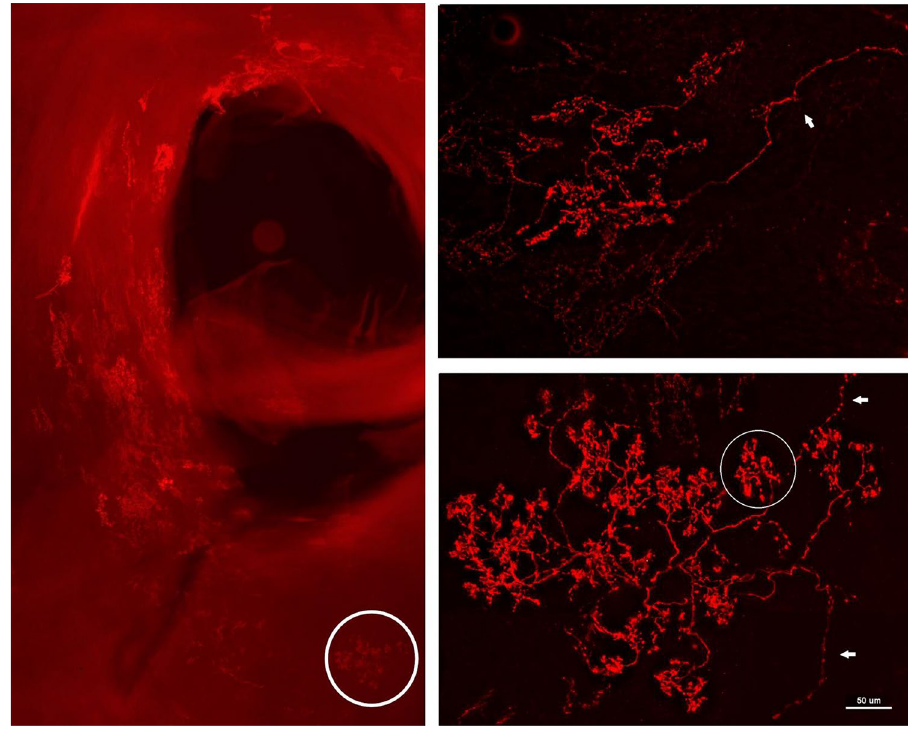
Figure 1. Illustration of baroreceptors in aortic artery. Left: baroreceptor distribution. The sensory receptors are clustered in different areas along the aortic artery. They are more concentrated in the bifurcation origin of the common carotid and subclavian arteries. The white circle shows the BR structure illustrated on the right (bottom). Right: sensory structures presented in compact clusters resembling bunches of grapes. Morphologically, receptor terminals, similar to airway mechanoreceptors, swell to form knob-like or leaf-like end-formations. A single parent axon may connect with multiple sensory receptor structures, indicated by white arrows. The white circle at the right bottom encircles a single BR. The scale bar is 50 µm.